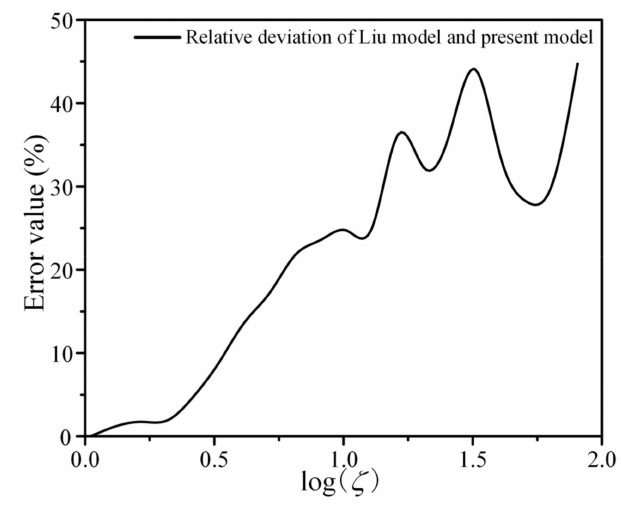
Figure 13. The error ratio between the Liu model and the present